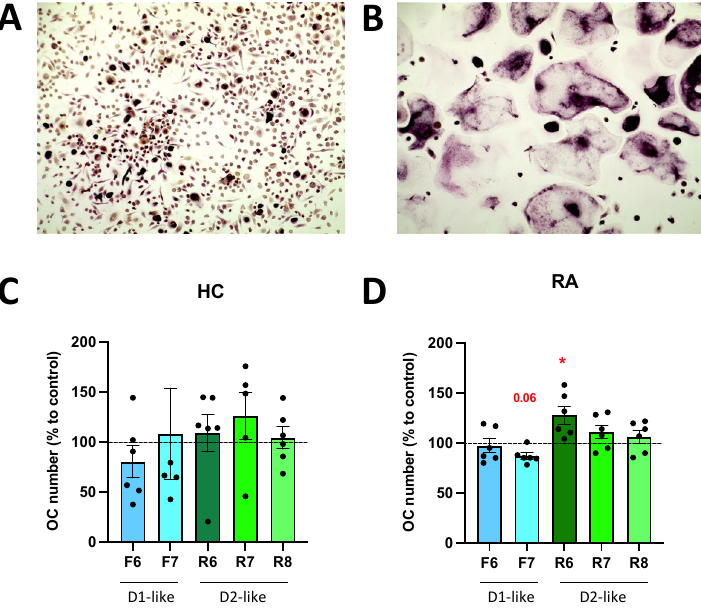
Figure 7. DR stimulation affects osteoclastogenesis. PBMCs were cultured with MCSF alone ( A ) or MCSF and RANKL ( B ) for 14 days and then stained for TRAP. TRAP-positive cells with more than two nuclei were counted as osteoclasts. ( A , B ): representative pictures from one healthy control. Magnification 100×. ( C , D ): quantification of osteoclast after specific DR stimulation for 14 days during OC differentiation in HC ( C ) and RA ( D ) samples. Values are expressed as percentage to control without DR agonist. HC n = 6, RA n = 6. F = Fenoldopam; R = Ropinirole; 6 = 10 − 6 M; 7 = 10 − 7 M; 8 = 10 − 8 M. Single dots represent individual patients. Histograms show mean and SEM. Raw data were used for statistical analysis with Wilcoxon matched pairs signed rank test. * = p < 0.05. p -value near to significance ( p = 0.06) are indicated in the figure.